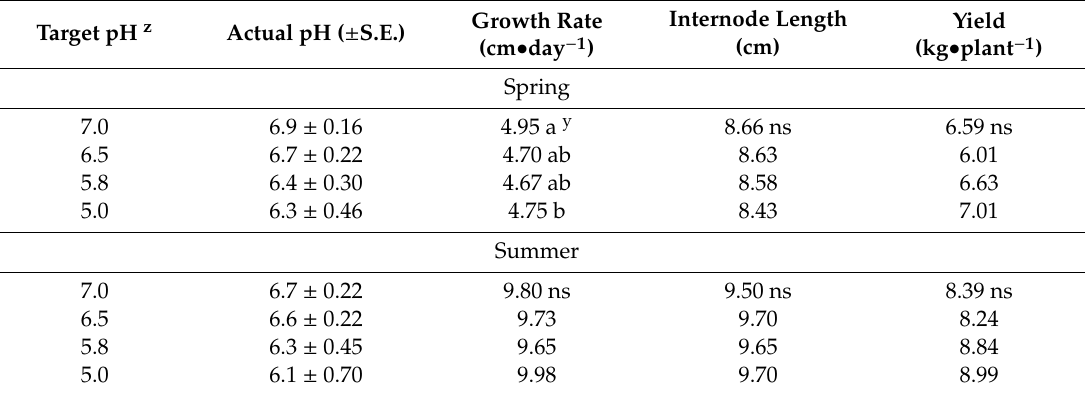
Table 1. Growth and yield of aquaponic cucumber at four pH